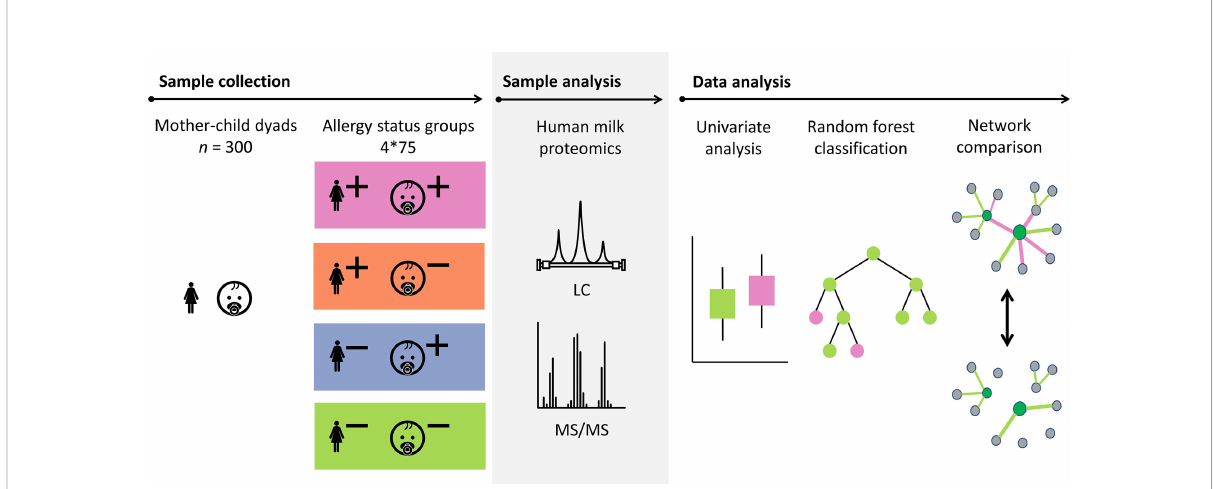
FIGURE 1 Schematic overview showing the sample set from the CHILD Cohort Study and the approach that was used for the analysis of the data. Proteins in a selection of 300 human milk samples from mother-child dyads with different allergy status (+ indicates allergy, - indicates no allergy) were analyzed using mass spectrometry. The data analysis was carried out using univariate analysis, classi fi cation models, and network comparison. Probabilistic Context Likelihood of Relatedness on Correlation (PCLRC), differential connectivity, and Covariance Simultaneous Component Analysis (COVSCA) were used for the network